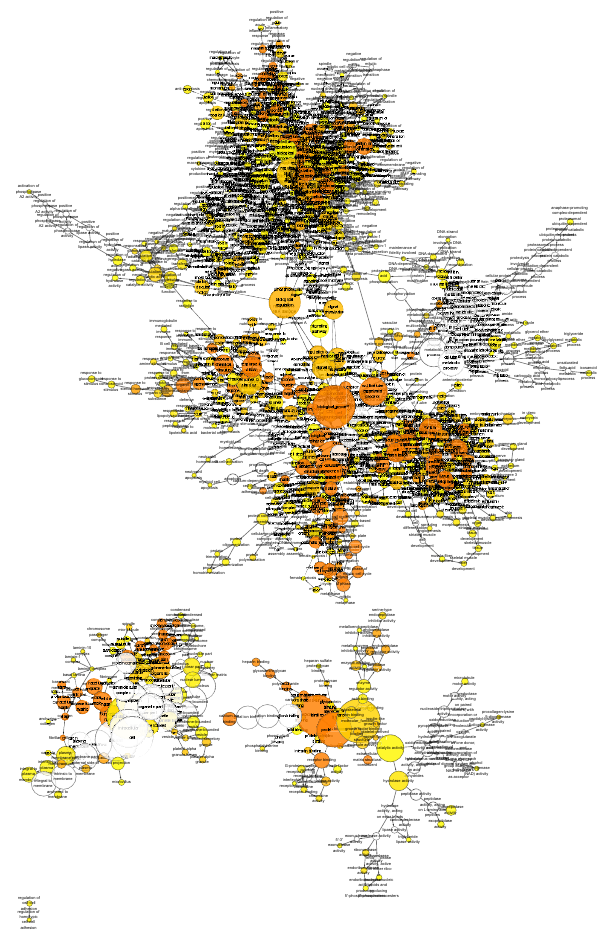
Figure 3. Enrichment analysis of DEGs. The deeper color the higher degree of enrichment. [The figure was created by Bingo plug-in in Cytoscape (https ://cytos